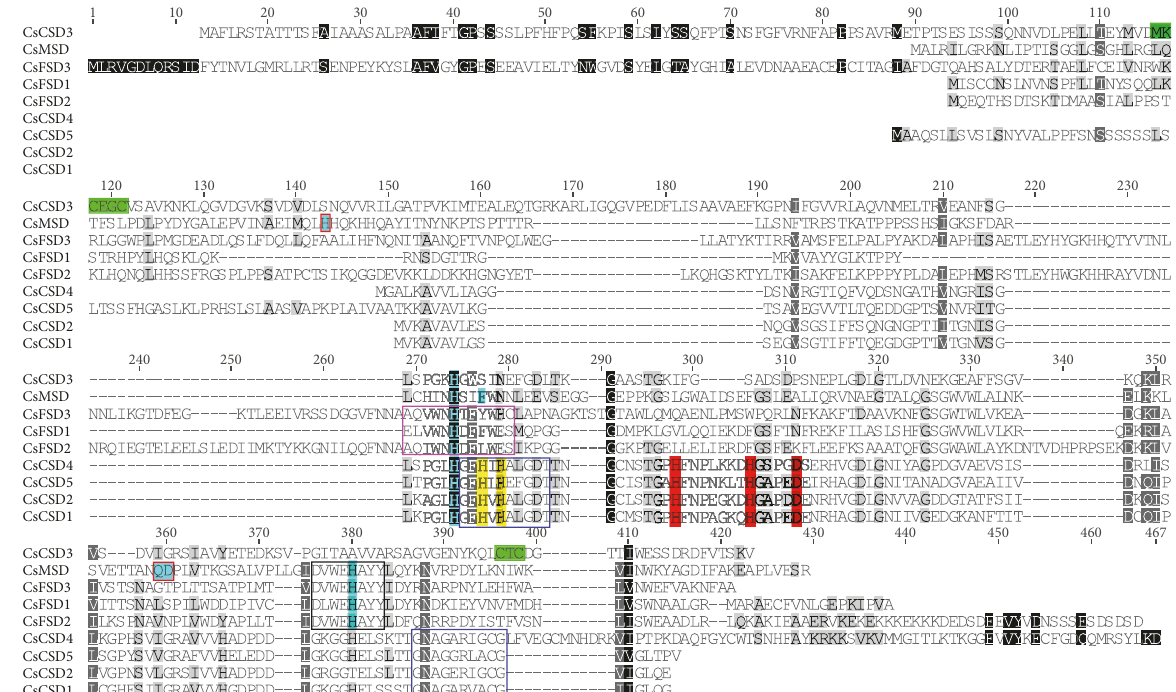
Figure 2: Multiple sequence alignment of deduced amino acid sequences of CsSOD proteins. Cu/ZnSOD signatures (GFH[VLI]H[EA][FL]GDTT and GNAG[GAE]R[VLI]ACG) are boxed in blue. The metal-binding sites for Cu 2+ and Zn 2+ are highlighted with yellow and red, respectively. The conserved metal-binding domain (DVWEHAYY) for Fe-MnSOD is in black box. The signature ([AE][QL][VI]WNH[TD]F[YFL]W[EH][CS]) responsible for the recognition of iron ion by FeSODs is boxed in pink. The conserved metal-binding motifs (MxCxxC and CxC) of CsCSD3 are highlighted in green. Six metal-binding sites in MnSOD are marked with cyan, and three residues (His, Gln, and Asp) that are present only in MnSOD and absent in FeSODs are marked with cyan in red